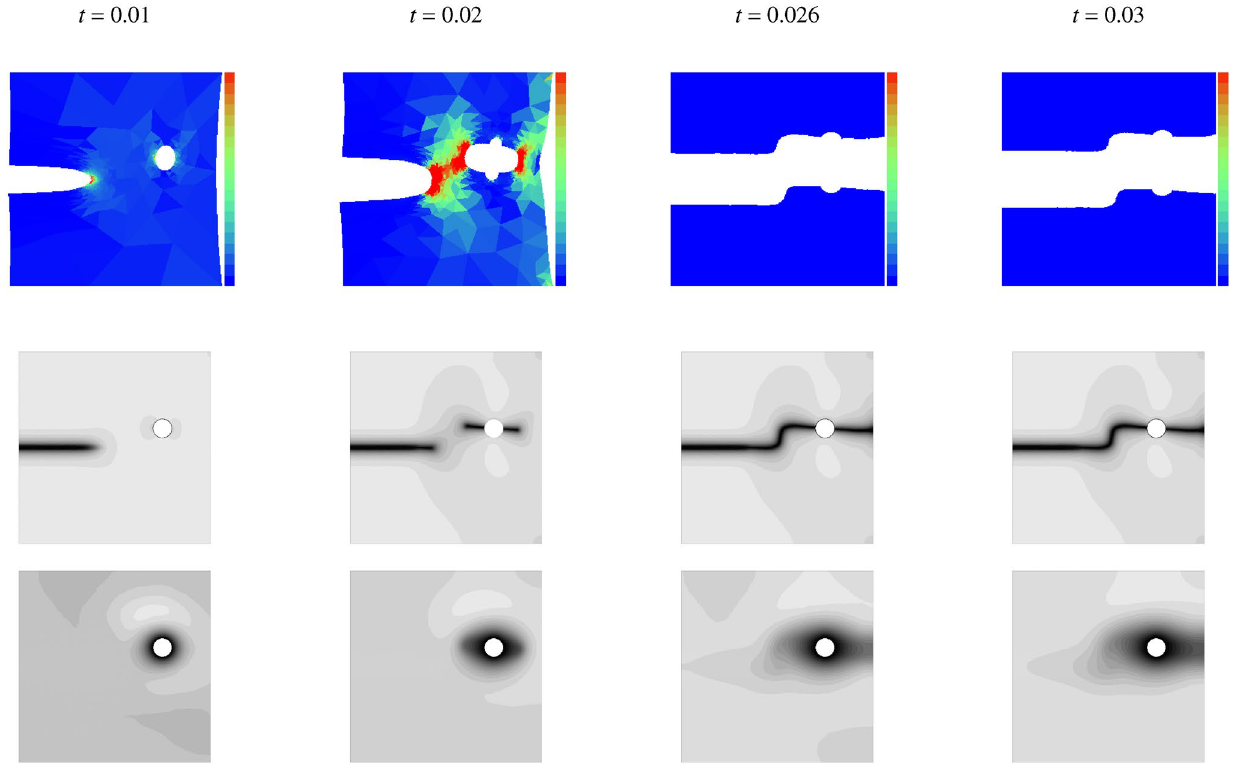
and w (bottom)) . In the upper figures, blue color indicates low val- ues, red color high values of the intensity of when D